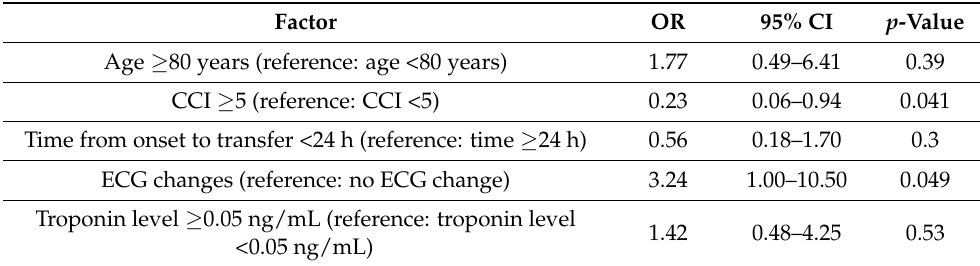
Table 2. Results of the logistic regression